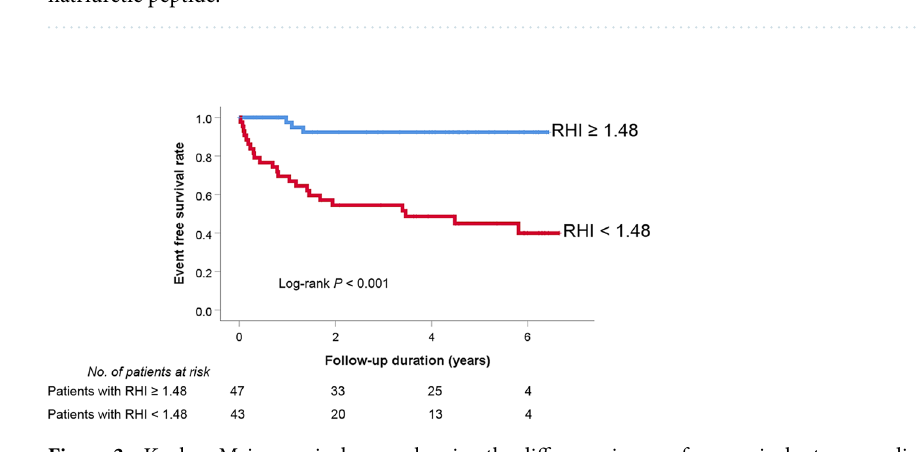
Figure 3. Kaplan–Meier survival curve showing the difference in even free survival rates according to RHI value ROC, receiver operating characteristic; RHI, reactive hyperemia